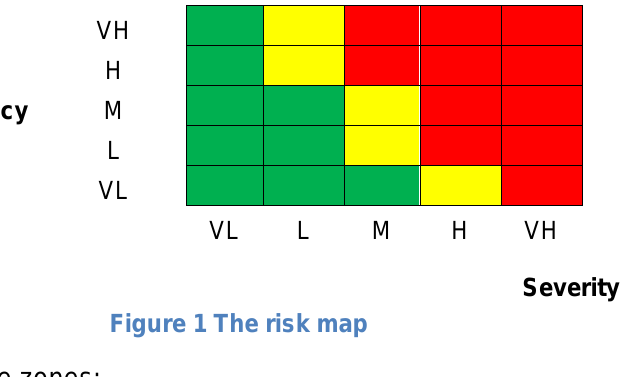
Figure 1 The risk